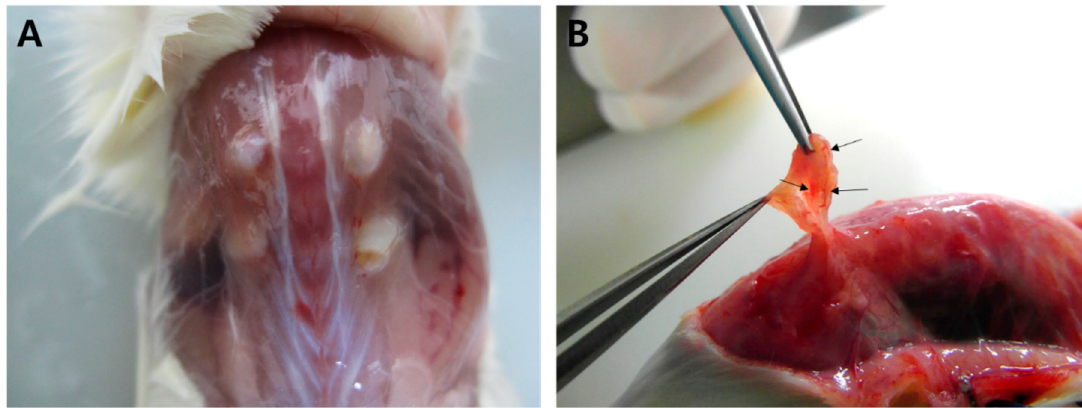
Figure 1. Data on grafted tissue. ( A ) Gross finding of grafted human ovarian tissue at 4 weeks after xenotransplantation on the back muscle of ovariectomized SCID mice. ( B ) The grafted tissue survived and the formation of vessels between the tissue fragment and grafted site was identified (arrows).